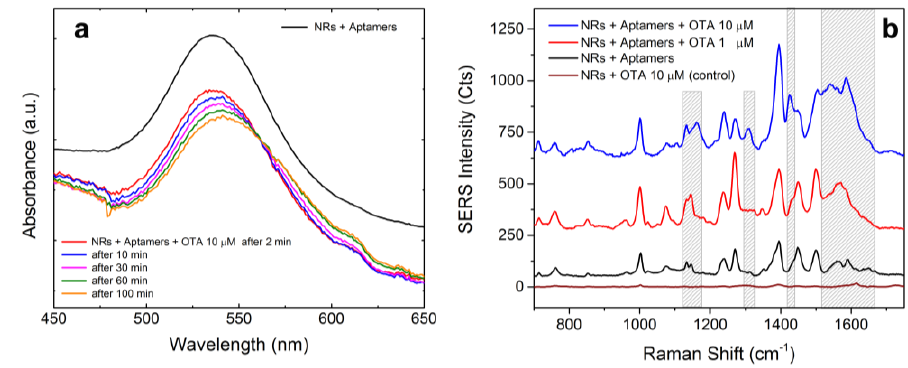
Figure 11. ( a ) Extinction spectra of aptamers-functionalized NRs after 60 min (black line). Addition of OTA (10 µM) causes a progressive shift and broadening of the NRs LSPR (colored lines), due to the interaction between aptamers and OTA molecules. ( b ) LIQUISOR SERS spectrum of aptamers for OTA (black line—P = 5 mW, T = 1 s) compared with the SERS spectrum observed from induced aggregates formed by functionalized NRs mixed with OTA 10 µM (blue line—P = 5 mW, T = 1 s) and 1 µM (red line—P = 5 mW, T = 1 s). Brown line is the spectrum coming out from aggregates spontaneously deposited on the bottom of the glass microcell after mixing NRs and OTA 10 µM without DNA aptamers (P = 18 mW, T = 1 s—in the figure, the spectrum is normalized to P = 5 mW for a better comparison with the other spectra). Dashed boxes highlight the spectral regions where the most evident differences can be observed. All the SERS spectra are averaged over at least 100 consecutive spectra. Data are offset for clarity.